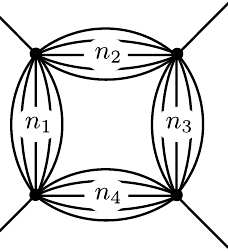
) . The Landau curve that is , n , n , n 1 2 3 4